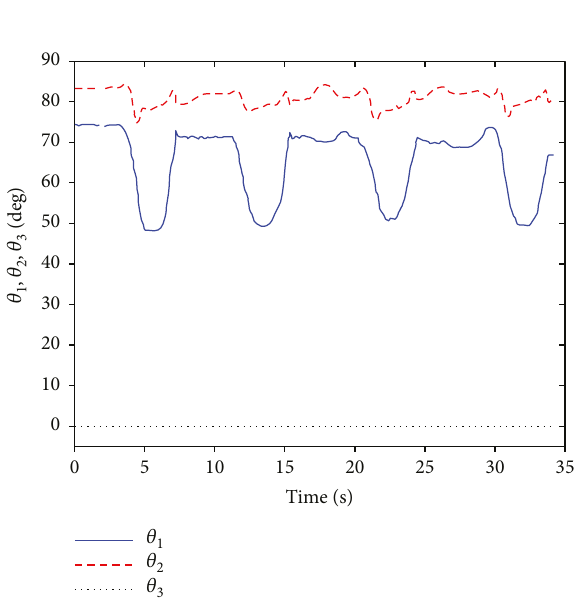
initial position.